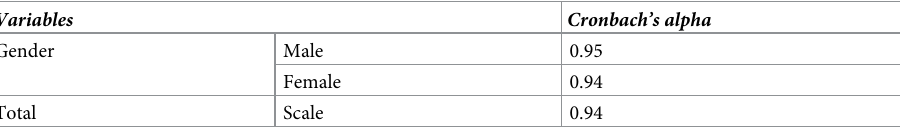
Table 1. Statistical indicators for